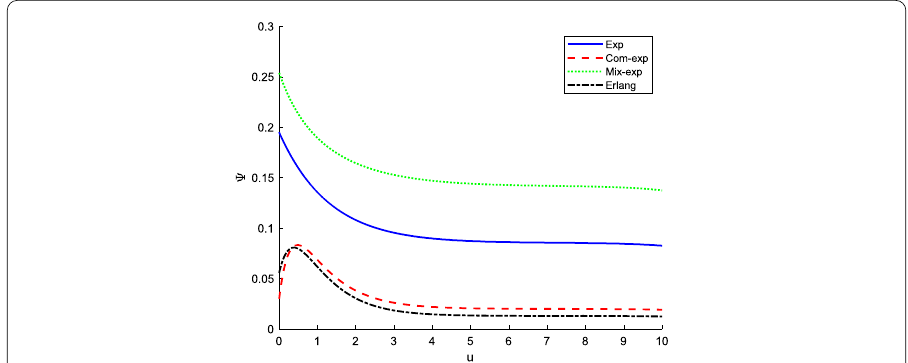
Figure 6 The expected discounted capital injection until ruin